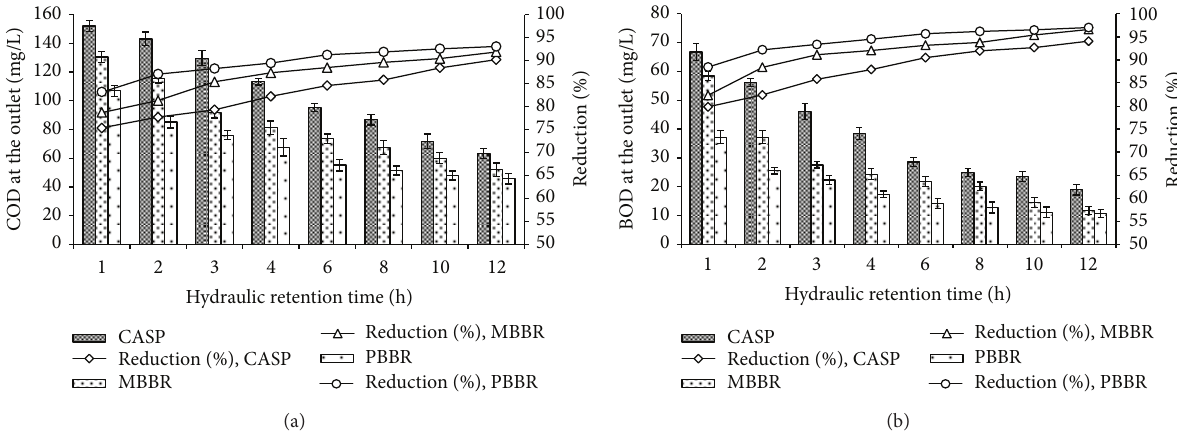
Figure 2: Average COD (a) and BOD 5 (b) values of treated effluents through the biological processes. The values represent the mean of five replicates ± standard error (SE).